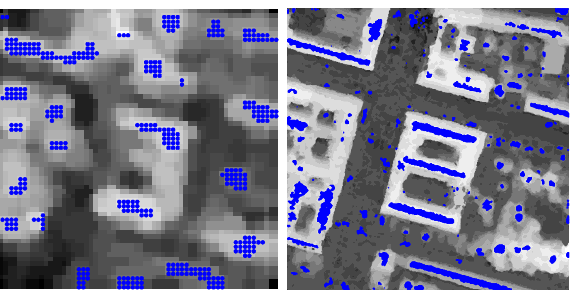
Figure 2: DSMs showing the same area with detected local highest points (blue). Left: CartoSat DSM with 5 m spatial resolution; Right: WV2 DSM with about 1 m spatial resolution.